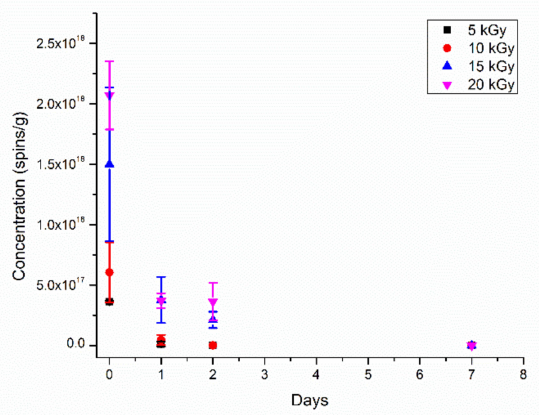
Figure 3. Time dependence radical concentration decay for PLA samples after irradiation at 5 kGy, 10 kGy, 15 kGy, and 20 kGy. The values at day 0 on the x-axis correspond to spectra that were taken a couple of hours after irradiation and kept in dry ice.